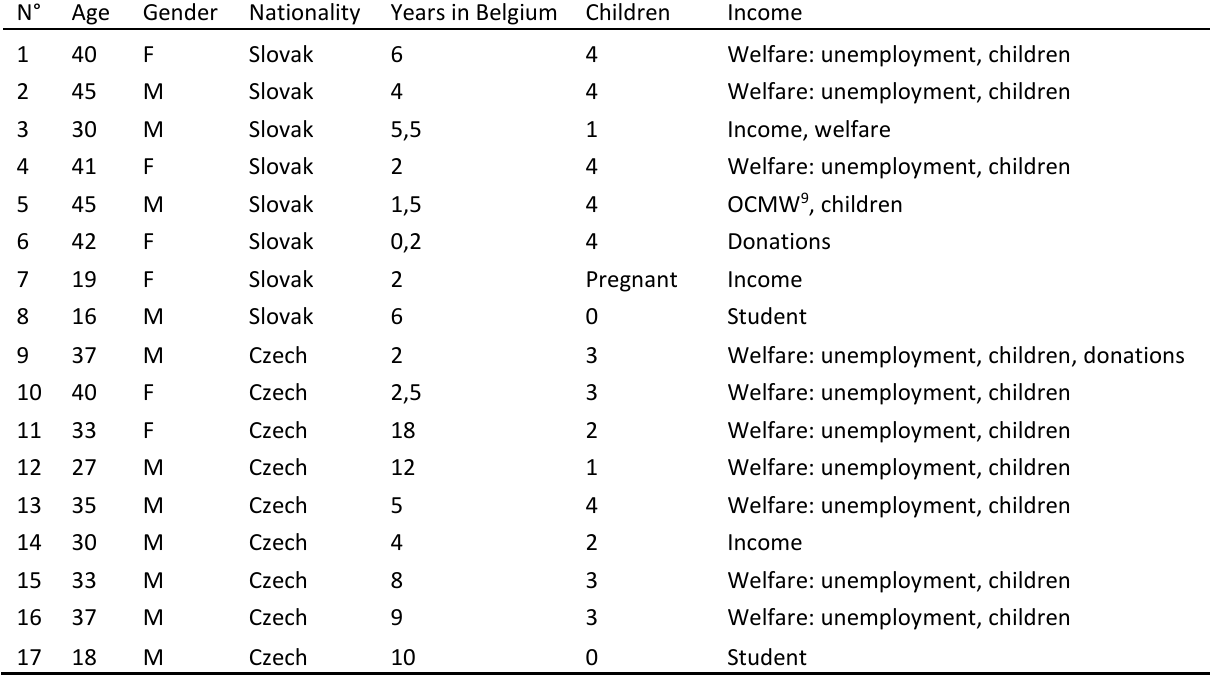
Table 1 . General characteristics of respondents (age; gender; nationality; time of residence in Belgium; number of chil- dren; source of